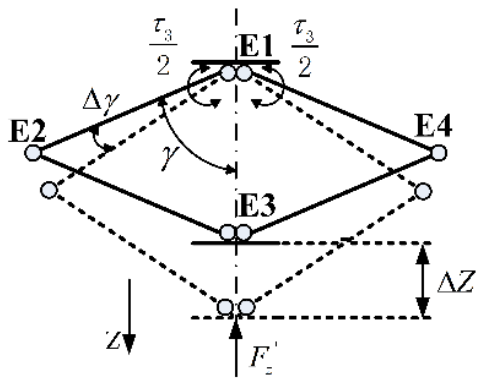
Figure 9. Model of virtual work.